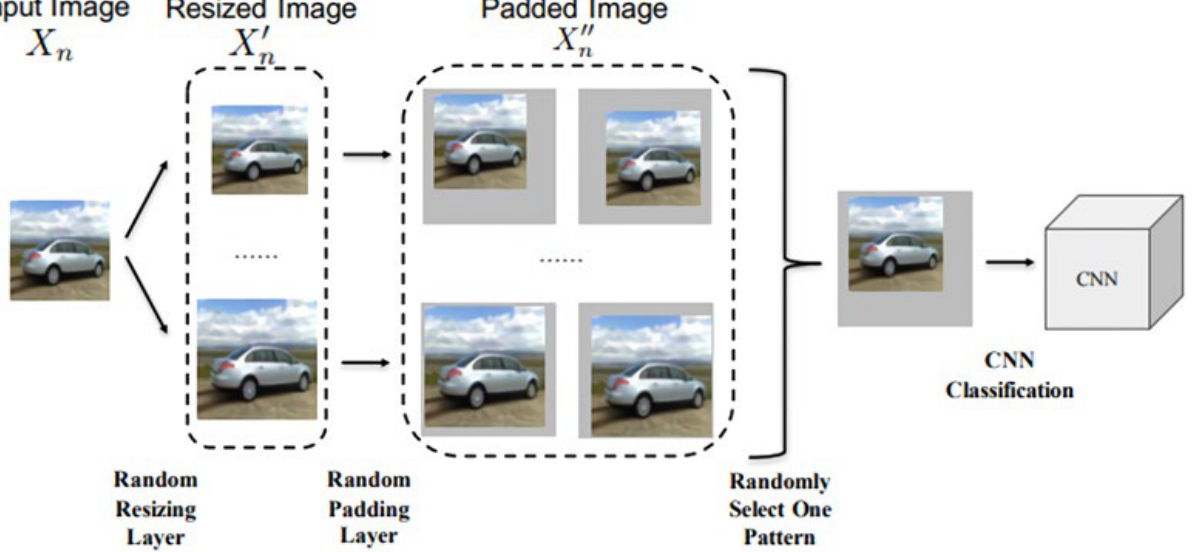
Figure 23. Pipeline of randomization-based defense mechanism. The RRP method involves trans- forming the input through random resizing and padding to make it difficult for an attacker to calculate the gradient of the loss on the input.